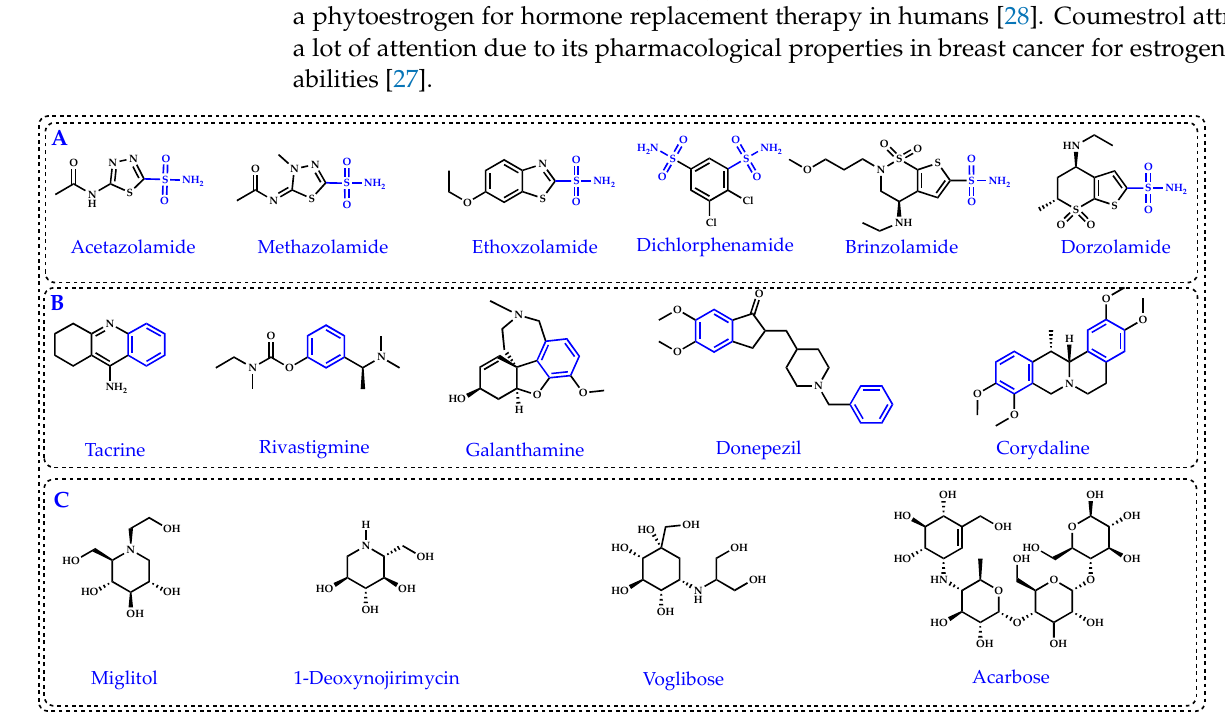
Figure 1. Commonly used standard inhibitors for carbonic anhydrase isoenzyme II (CA II) ( A ), for acetylcholinesterase (AChE) and butyrylcholinesterase (BChE) ( B ) and for α‐ glycosidase ( α‐ Gly) ( C ).